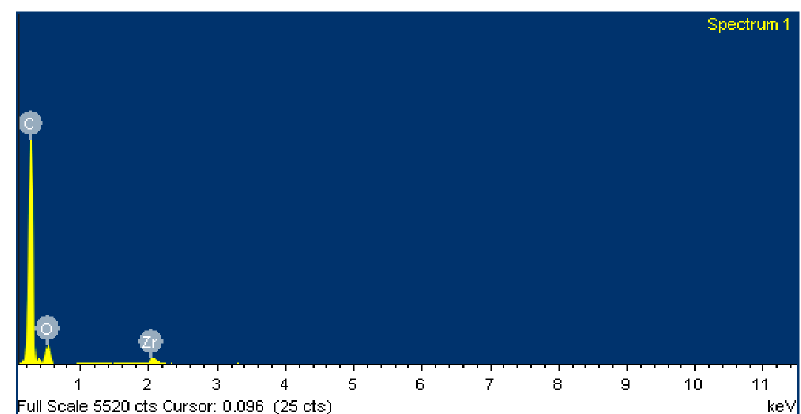
Figure 17. EDS spectrum for zone 2 in the PA46Z sample.